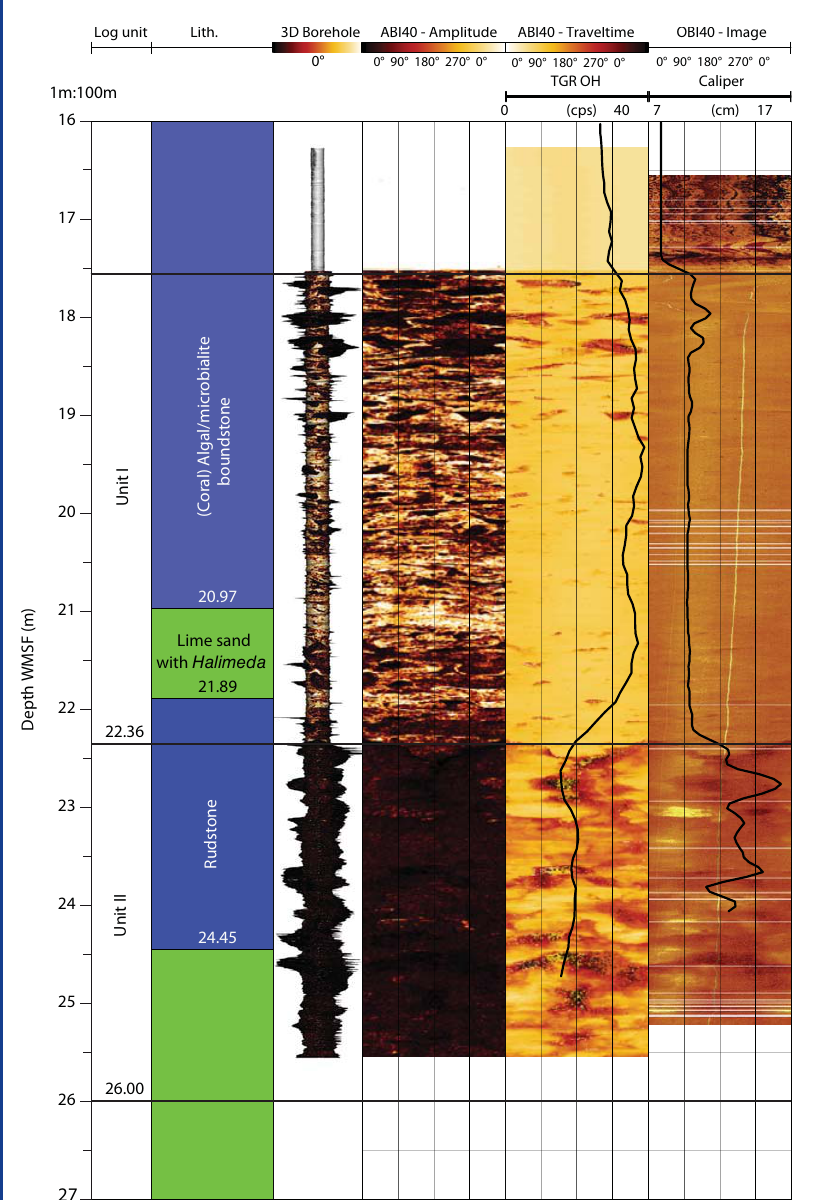
Figure 9. Examples of borehole logging data. The figure illustrates the detail obtained from the ABI40 tool and 3D virtual borehole, transect NOG-01B. (3D Borehole = 3D borehole visualization, ABI 40 traveltime image is overlain by total gamma ray (TGR), OH = open hole). Depth given as wireline log matched depth below sea floor